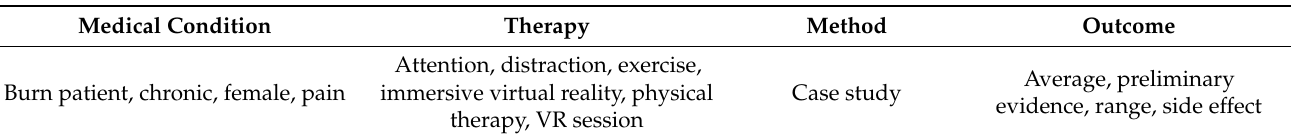
Table 6. Categorized terms associated with pain management (PM) from Figure 6 (devised by the